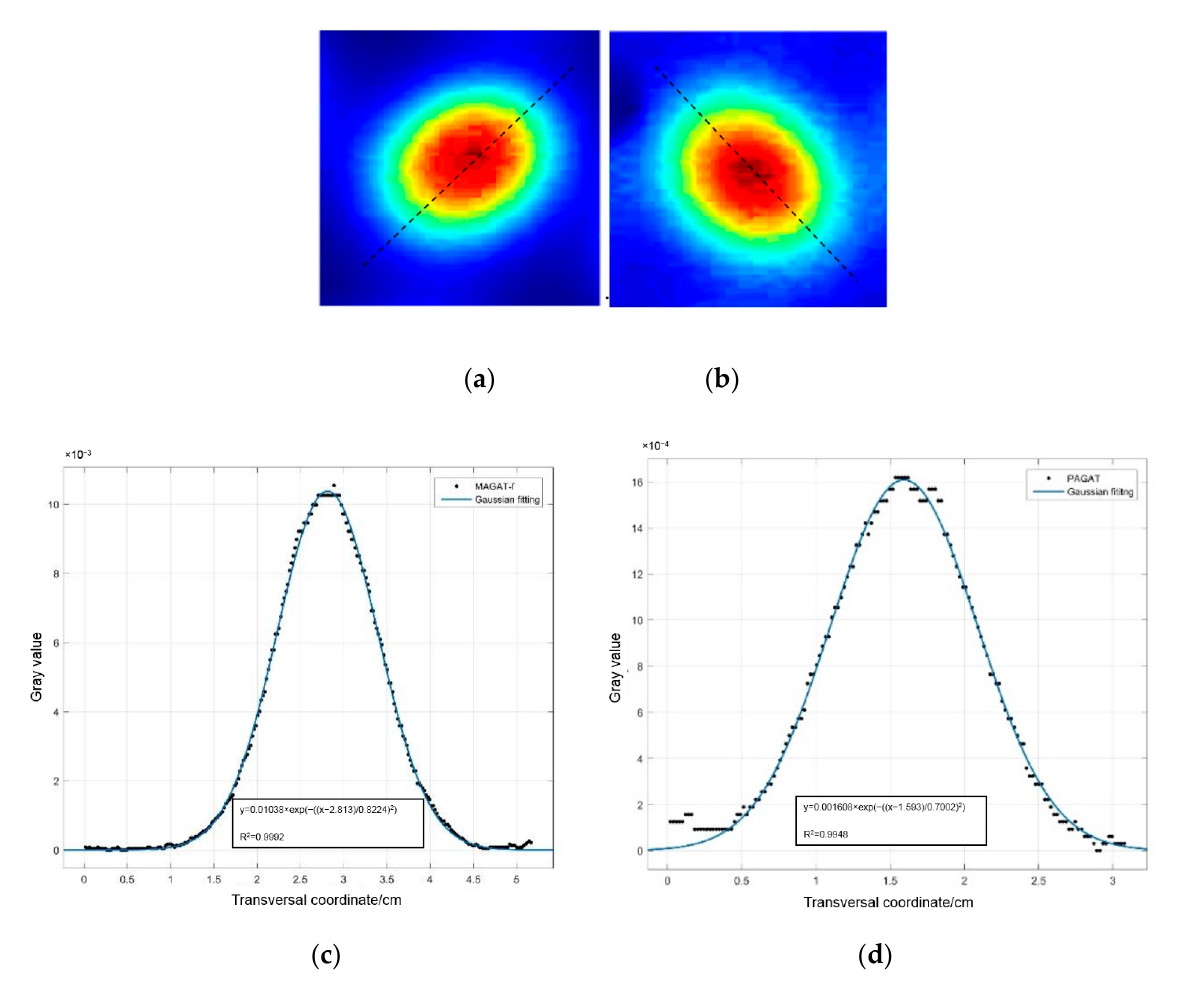
Figure 6. Proton beam spot measured with ( a ) MAGAT-f gel (top left) and ( b ) PAGAT gel (top right); the lateral profile of ( c ) MAGAT-f gel and ( d ) PAGAT gel (73.5 MeV). The spot size of energy 73.5 MeV simulated with the MC method was 5.83 mm. The deviations between the gel measurement and MC simulation were − 0.56% and − 14.23% for MAGAT-f and PAGAT gels, respectively.